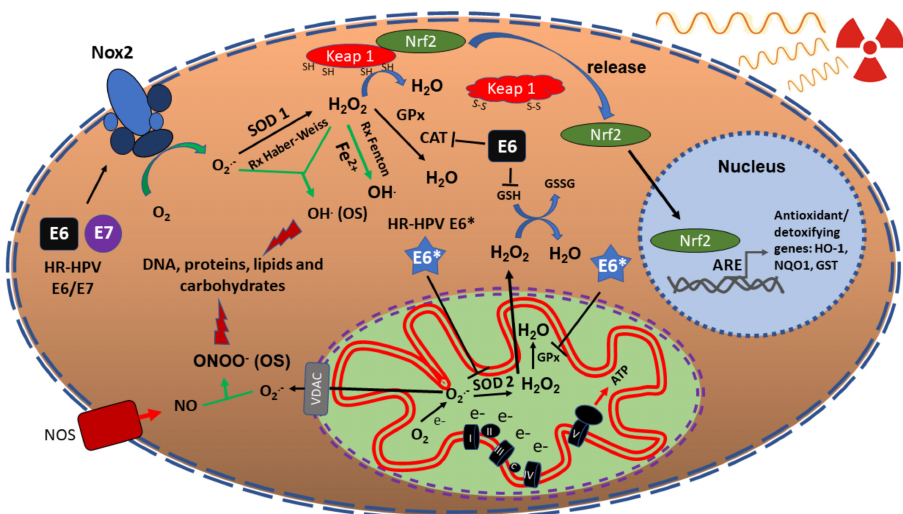
Figure 1. Redox state in irradiated HNSCC cells and the effect of HPV oncoproteins. HNSCC cells regulate oxidative stress induced by IR through the overexpression of Nrf2, which in turn activates genes such as catalase, superoxide dismutase (SOD2) and glutathione peroxidase (GPx), associated to antioxidant processes. On the other hand, the HR-HPV E6 protein induce OS, which decreases the GSH/GSSG rate, the levels of catalase and its activity [44]. E6* decreases SOD2 and GPx, provoking OS and consequently, DNA damage [45]. E6/E7 activate Nox2, inducing OS and DNA damage [46]. Therefore, altogether, HPV oncoproteins could sensitize HNSCC cells to radiation therapy. Nicotinamide adenine dinucleotide phosphate (NADPH) oxidase 2 (Nox2), superoxide dismutase (SOD), heme oxygenase (HO-1), NAD(P)H:quinone oxidoreductase 1 (NQO1), glutathione S-transferase (GST), glutathione peroxidase (GPx), catalase (CAT), glutathione (GSH), glutathione disulfide (GSSG), voltage-dependent anion channels (VDAC), peroxynitrite (ONOO − ), nitric oxide (NO), superoxide anion (O 2. − ), hydrogen peroxide (H 2 O 2 ), hydroxyl radical (OH . ), high-risk human Papillomavirus (HR-HPV), nuclear factor (erythroid-derived 2)-like 2 (Nrf2), antioxidant response elements (ARE), nitric oxide synthase (NOS). The red rays indicate the damage to DNA, protein, carbohydrates and